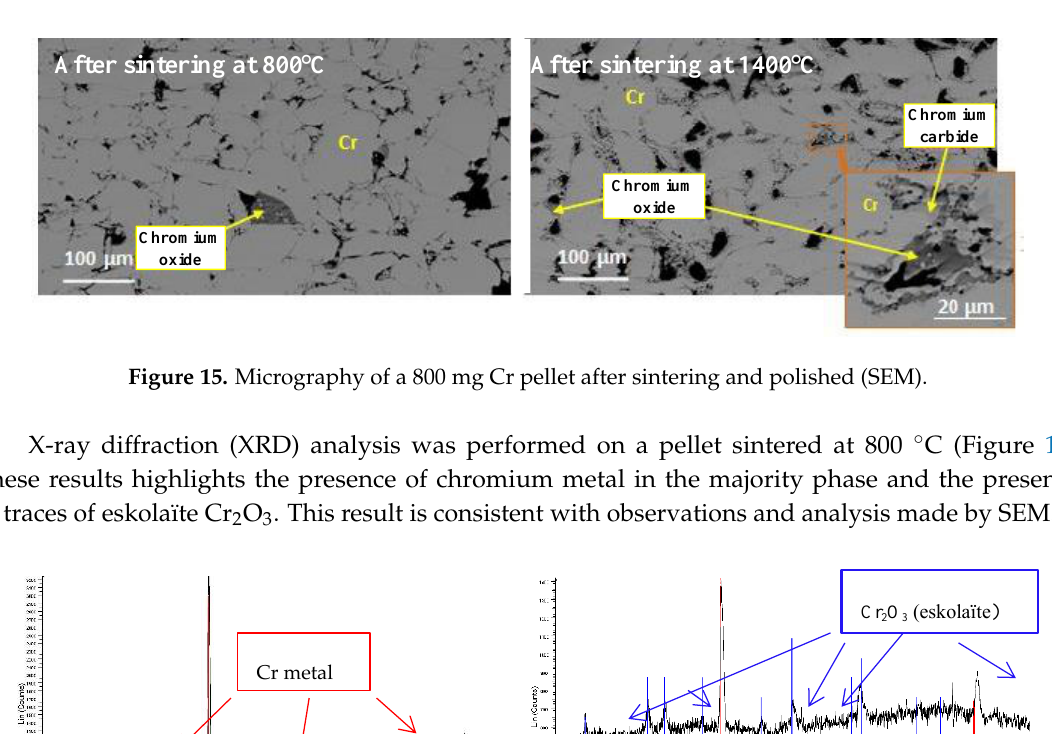
Figure 14. Micrography of a 800 mg Cr pellet before sintering (optical microscope).